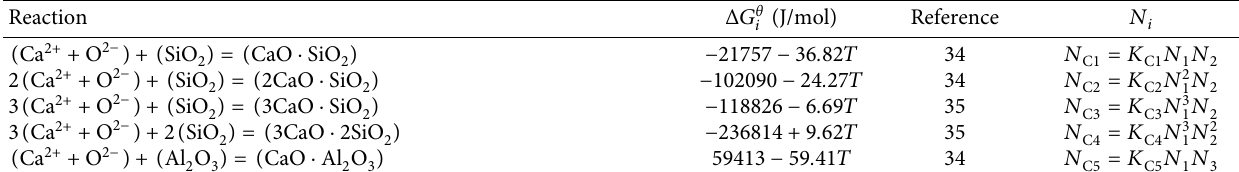
Table 5: Chemical reaction formulas of possibly formed complex